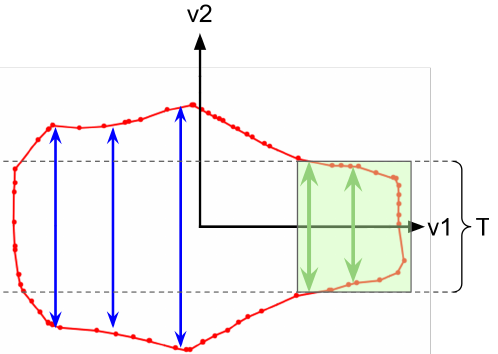
Figure 13. “Narrow” regions detection. The borders of the rock is represented in red. The v1 and v2 axes correspond to the coordinate system created with eigenvectors. T corresponds to the distance threshold used for the narrow detection process. The green arrows illustrate border-to-border distances that would be considered as valid for finding narrow regions, whereas the blue arrows are border-to-border distances that surpass the threshold defined by T. The green rectangle represents the narrow area detected in this